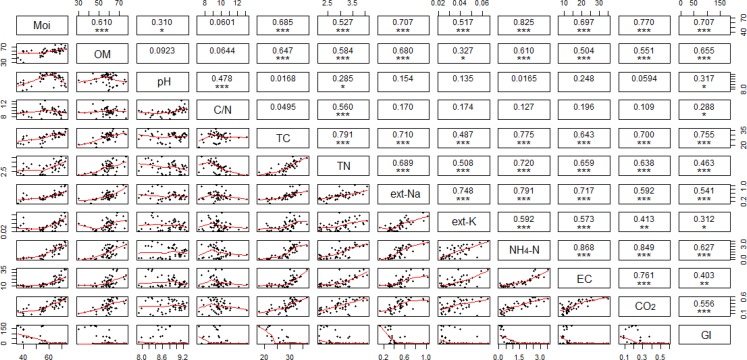
The correlation analyses of compost chemical and microbial properties over three composts.The diagonal shows the properties used for the correlation analyses; the lower triangle illustrates the x-y scatter plots of every two properties; and the upper triangle illustrates the correlation coefficient and p value of each correlation analysis. The *, **, and *** symbols represent significant levels of p<0.05, p<0.01, and p<0.001, respectively.